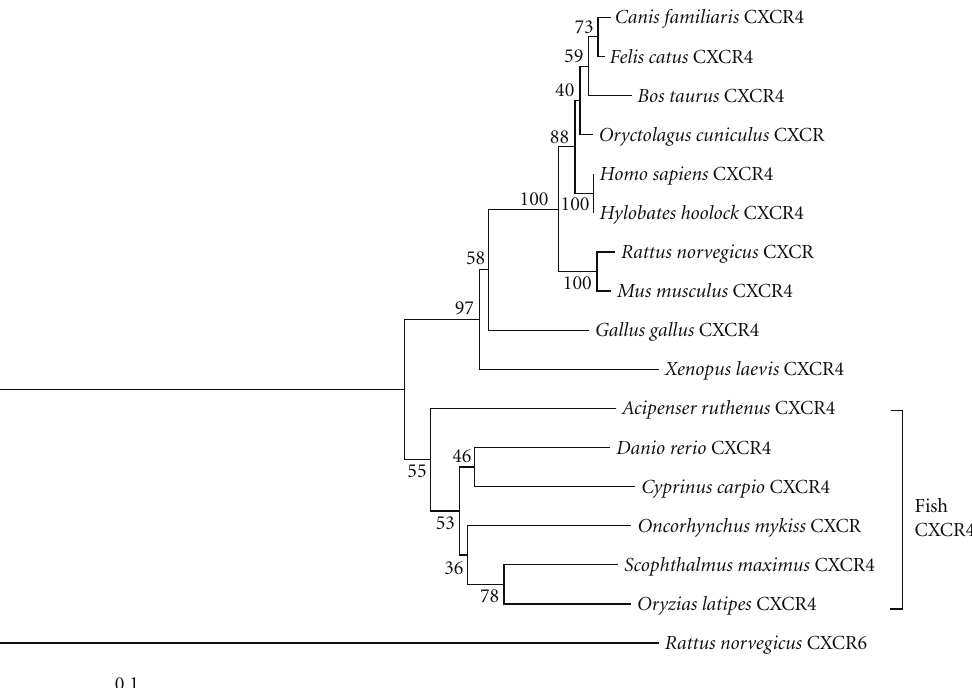
Figure 2: Neighbor-Joining tree of the amino-acid sequences of CXCR4. Numbers at tree nodes refer to percent bootstrap values after 1000 replicates; the scale bar refers to a phylogenetic distance of 0.1amino acid substitutions per site. CXCR6 of Rattus norvegicus was used as outgroup. Turbot CXCR4 is underlined. The GenBank accession numbers of the sequences are as follows, CXCR4: D. rerio , AAH50172 ; C. carpio , BAA32797 ; O. latipes , ABC41565 ; A. ruthenus , CAB60252 ; H. sapiens , CAA12166 ; Hylobates hoolock , AAF89348 ; Canis familiaris , ABA28309 ; Bos Taurus , AAI05218 ; G. gallus , AAG09054 ; M. musculus , BAA19187 ; Xenopus laevis , AAI10722 . CXCR: Oncorhynchus mykiss ,